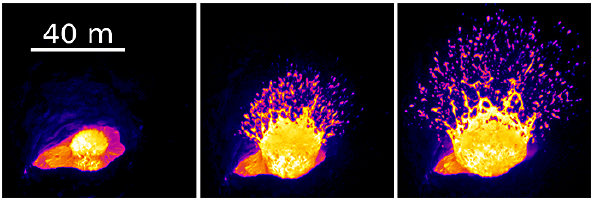
Fig. 5. A sequence of three IR images recorded ∼ 0.17s apart, showing the arrival of a large gas slug in the lava lake.